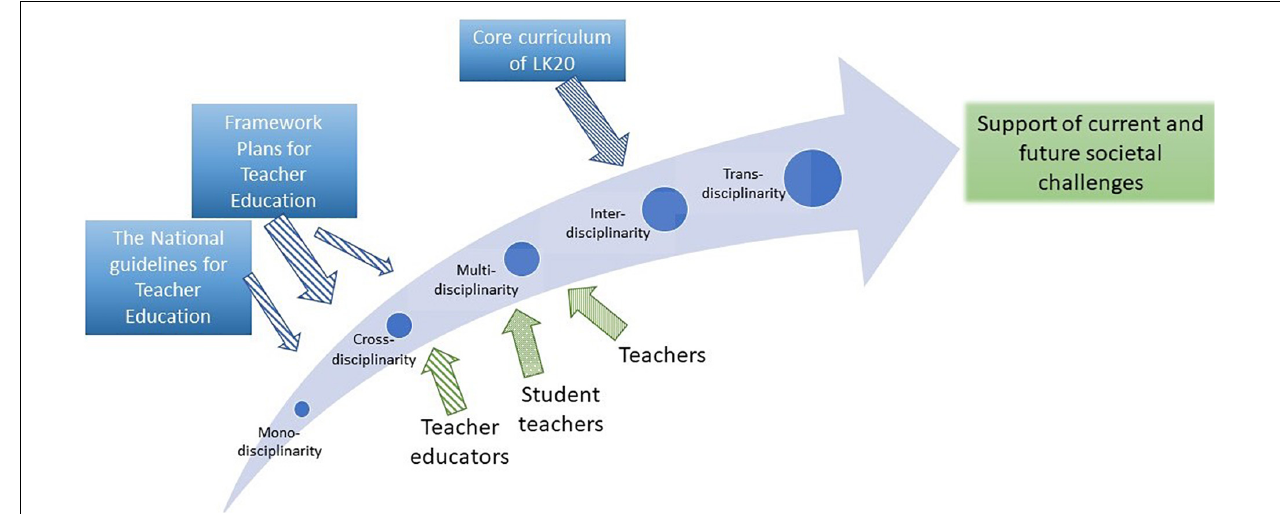
FIGURE 5 | Positioning the mandate assigned and the stakeholders